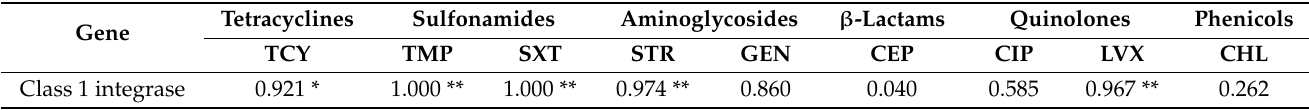
Table 2. Pearson correlation analysis of Class 1 integron and antibiotic resistance phenotype.